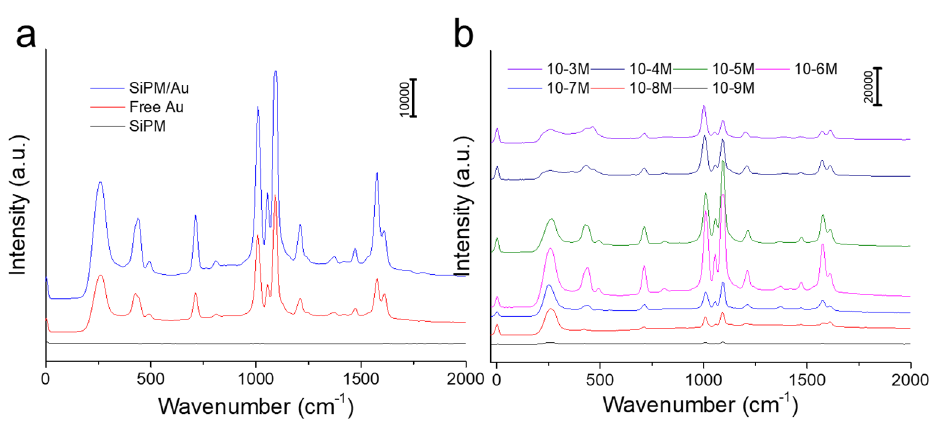
Figure 4. ( a ) SERS spectra of 10 − 6 M 4-MPy on SiPM, free Au, and SiPM / Au composites; ( b ) SERS spectra of 4-MPy on SiPM / Au with di ff erent concentrations (from 10 − 3 to 10 − 9